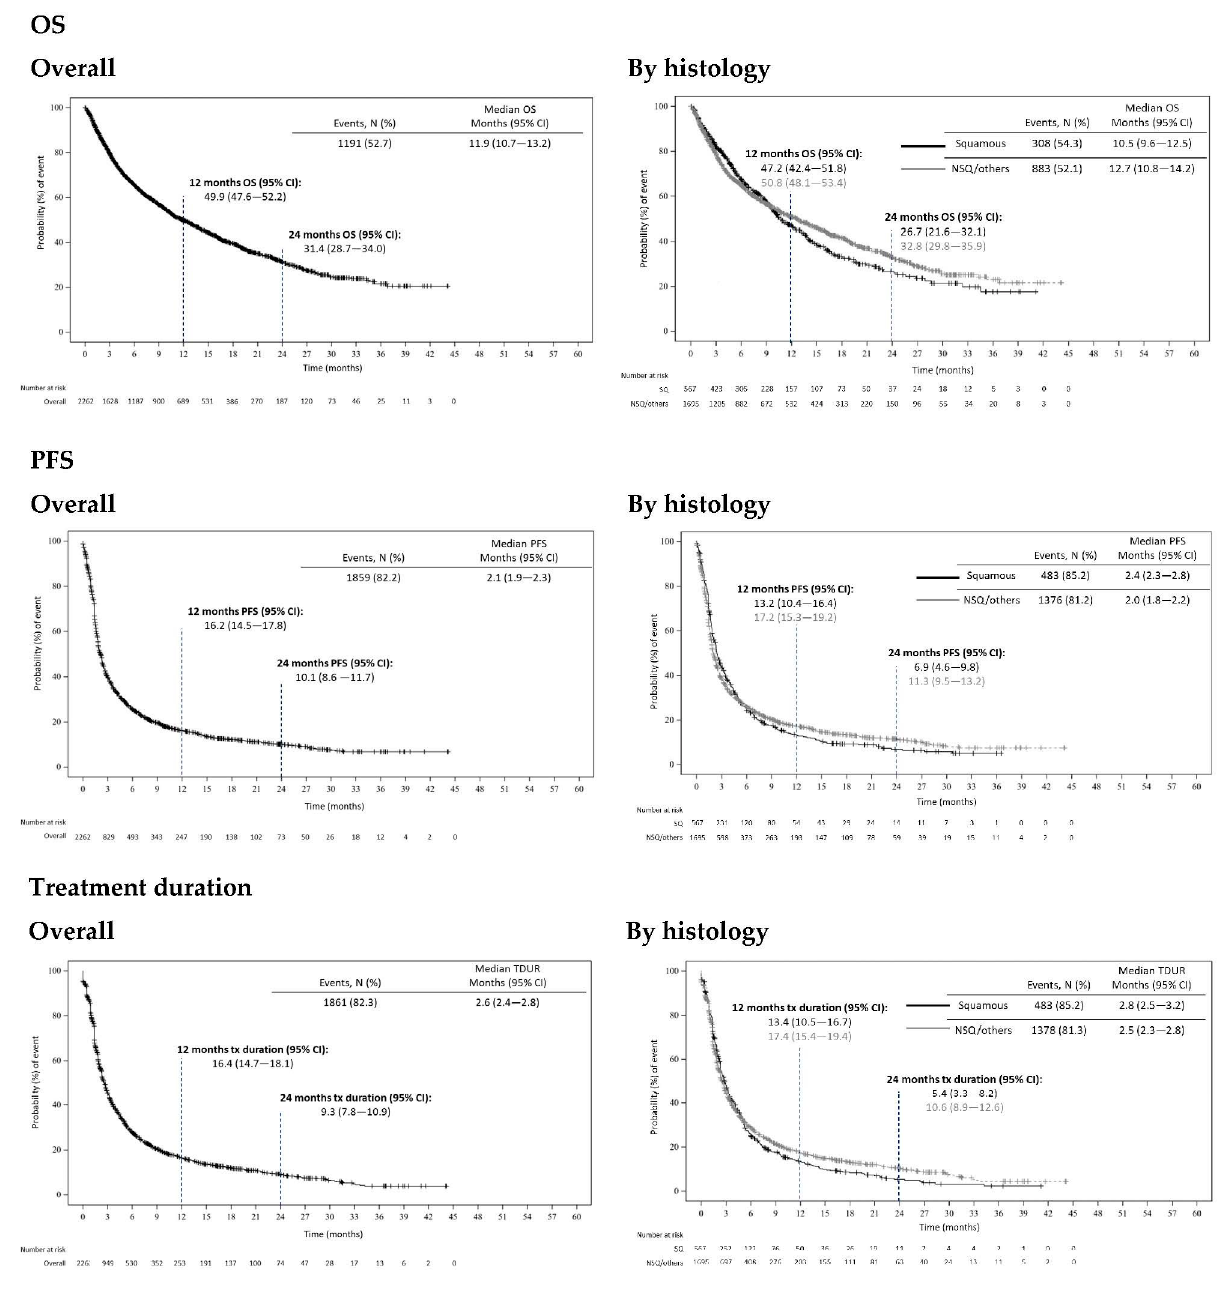
Figure 1. OS, PFS and treatment duration by histology in patients treated with nivolumab in ESME- AMLC (index date=nivolumab start date).